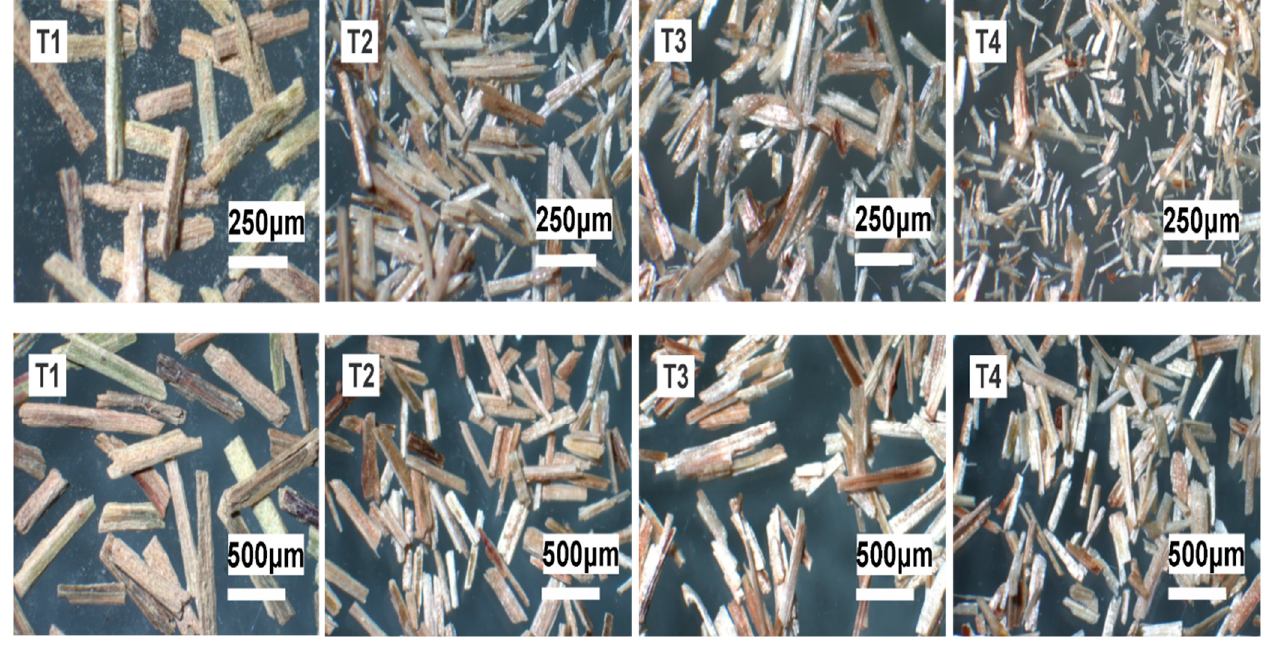
Figure 10. Geometry of the obtained biosorbents (white bars indicate 250 and 500 µm).